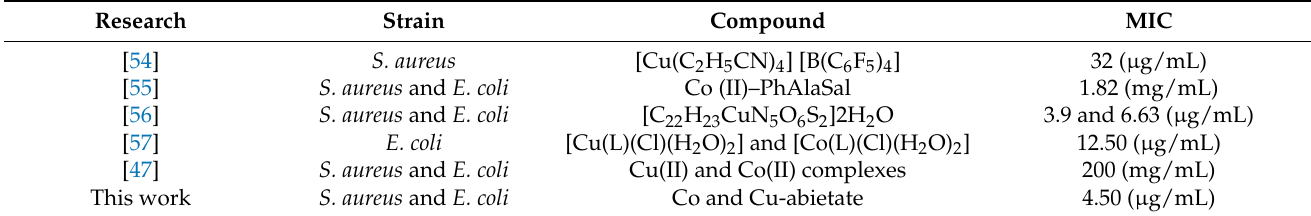
Table 2. MICs from different